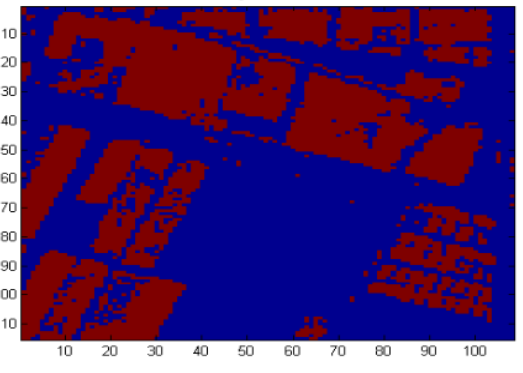
Figure (4)- The output change map